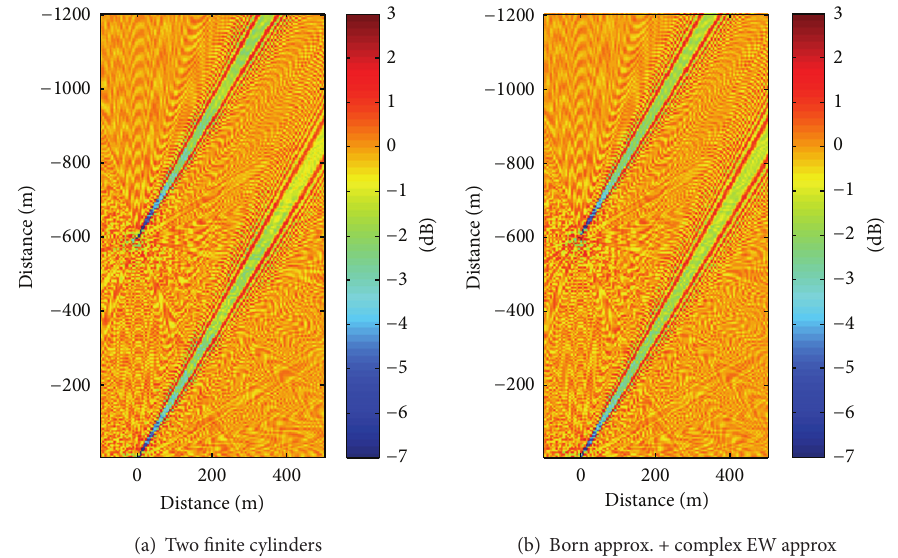
Figure 8: (a) Near-field distribution around two finite 3D cylinders at 500 MHz computed using the full-wave solver. (b) Near-field distribution around two infinite cylinders generated using the complex EW and the Born approximations.